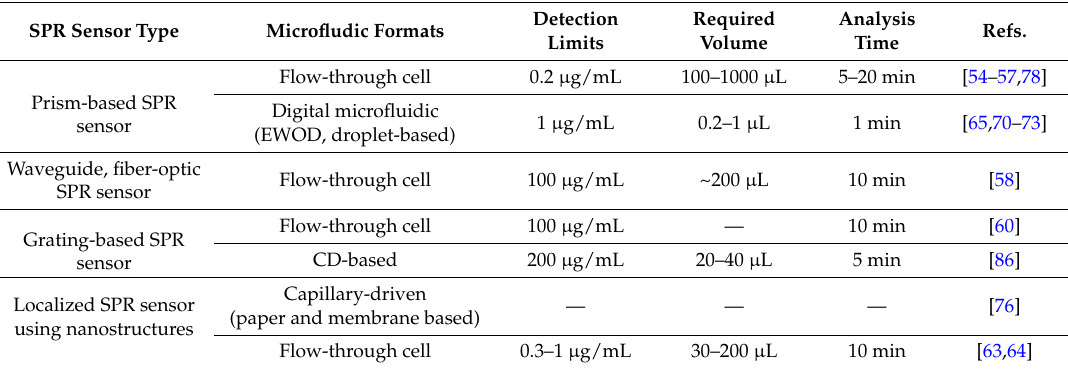
Table 1. Summary of various microfluidic SPR sensor